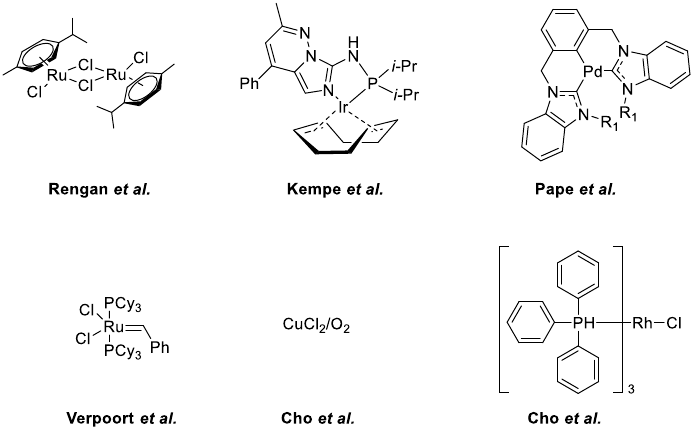
Figure 4. Metal catalysts used in indirect Friedländer annulation.